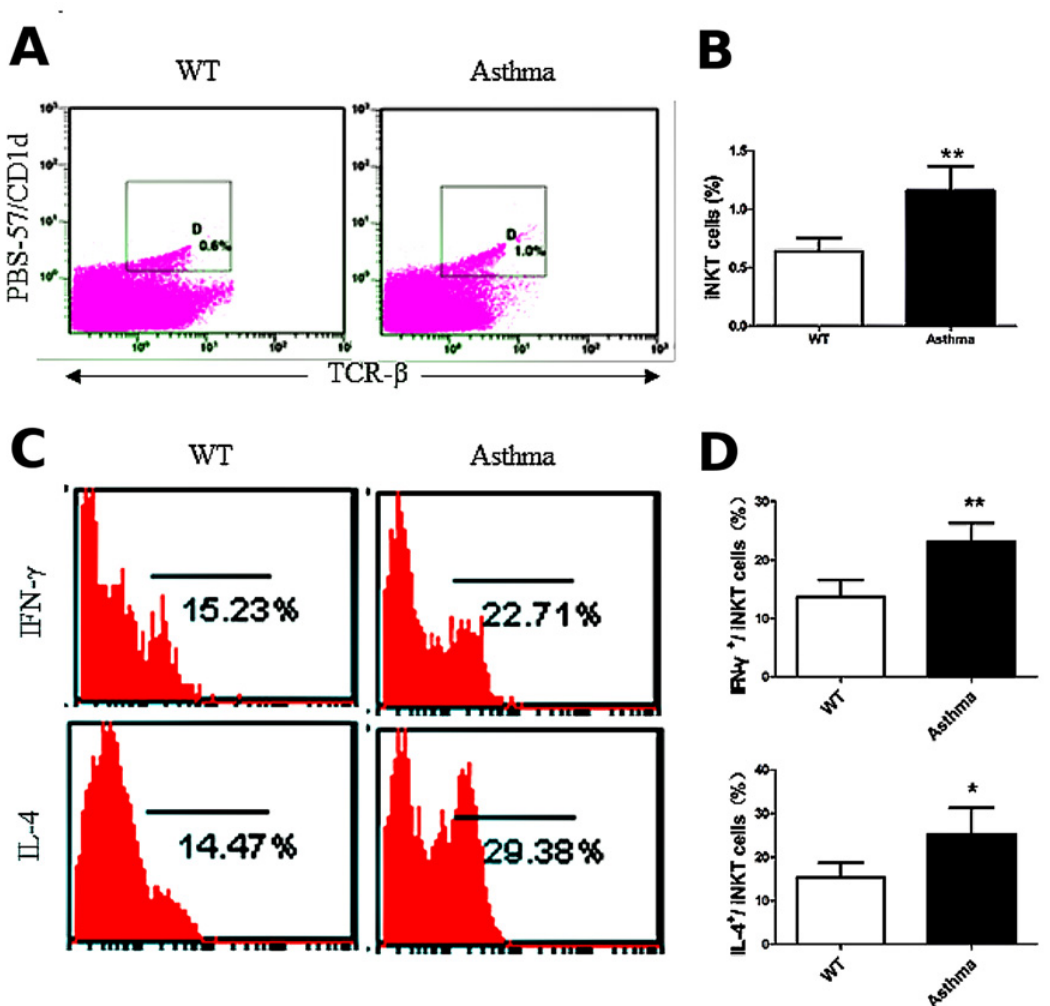
Fig 3. iNKT cells are activated in the OVA-induced asthma model. A. The percentage of iNKT cells (PBS-57/CD1d + TCR- β + ) in lung MNCs. The gating used for iNKT cells (gate D) and the corresponding percentages are shown in each dot plot. B . Percentage of iNKT cells in lung MNCs from OVA-induced asthmatic mice and WT mice. N = 5 per group and ** P < 0.01. C . Lung iNKT cells producing IFN- γ and IL-4. PBS-57/CD1d and TCR- β double-positive cells were examined for IFN- γ (top) and IL-4 (bottom) secretion. Numbers in each dot plot indicate the percentage of positive cells. D . Percentage of IFN- γ - and